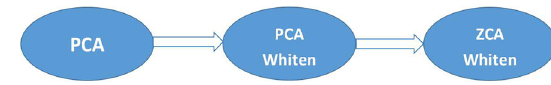
Fig. 1 ZCA whitening flow chart